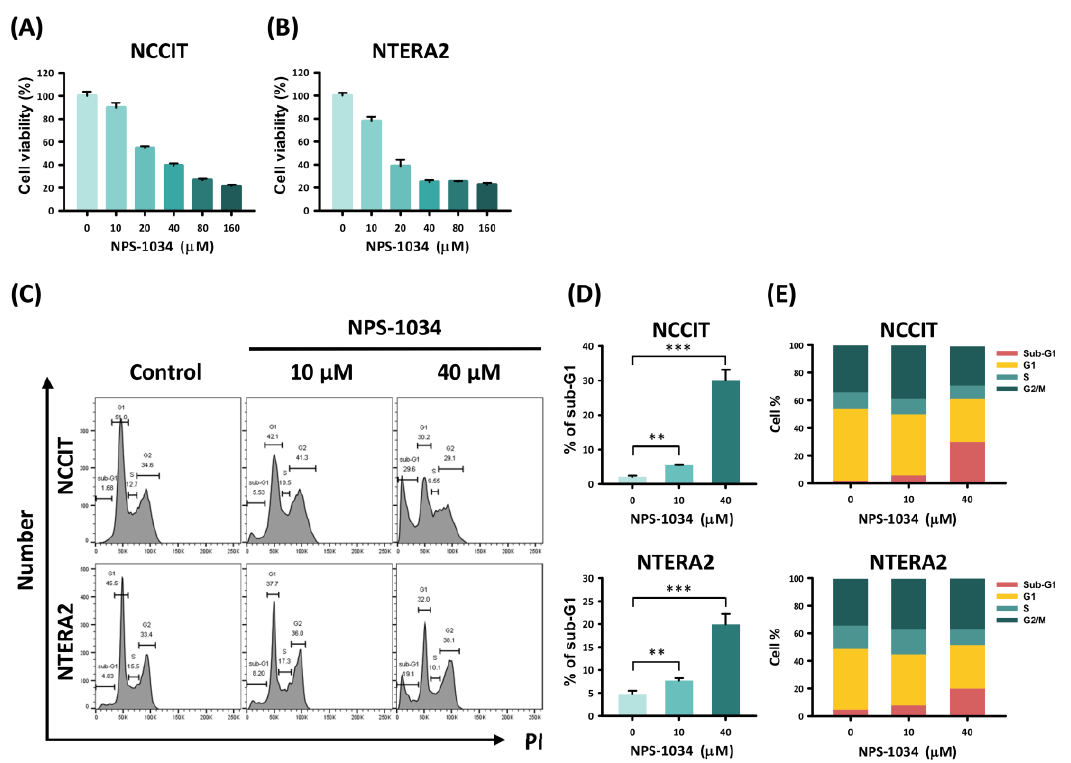
Figure 1. Analysis of TC cell survival with NPS-1034 treatment. The MTT assay was used to determine TC cell viability in ( A ) NCCIT and ( B ) NTERA2 cell lines treated with NPS-1034 (10, 20, 40, 80, and 160 µM) and DMSO (control) for 24 h. ( C ) Cell cycle analysis was performed to evaluate changes in each phase of NCCIT and NTERA2 cell lines treated with NPS-1034 at 10 and 40 µM for 48 h. ( D ) An increase in the sub-G1 phase can be observed in both cell lines after NPS-1034 treatment. ( E ) The proportion of the cell cycle was quantified in the segments of the bar chart. The data are presented as mean ± SD (** p < 0.01; *** p < 0.001).